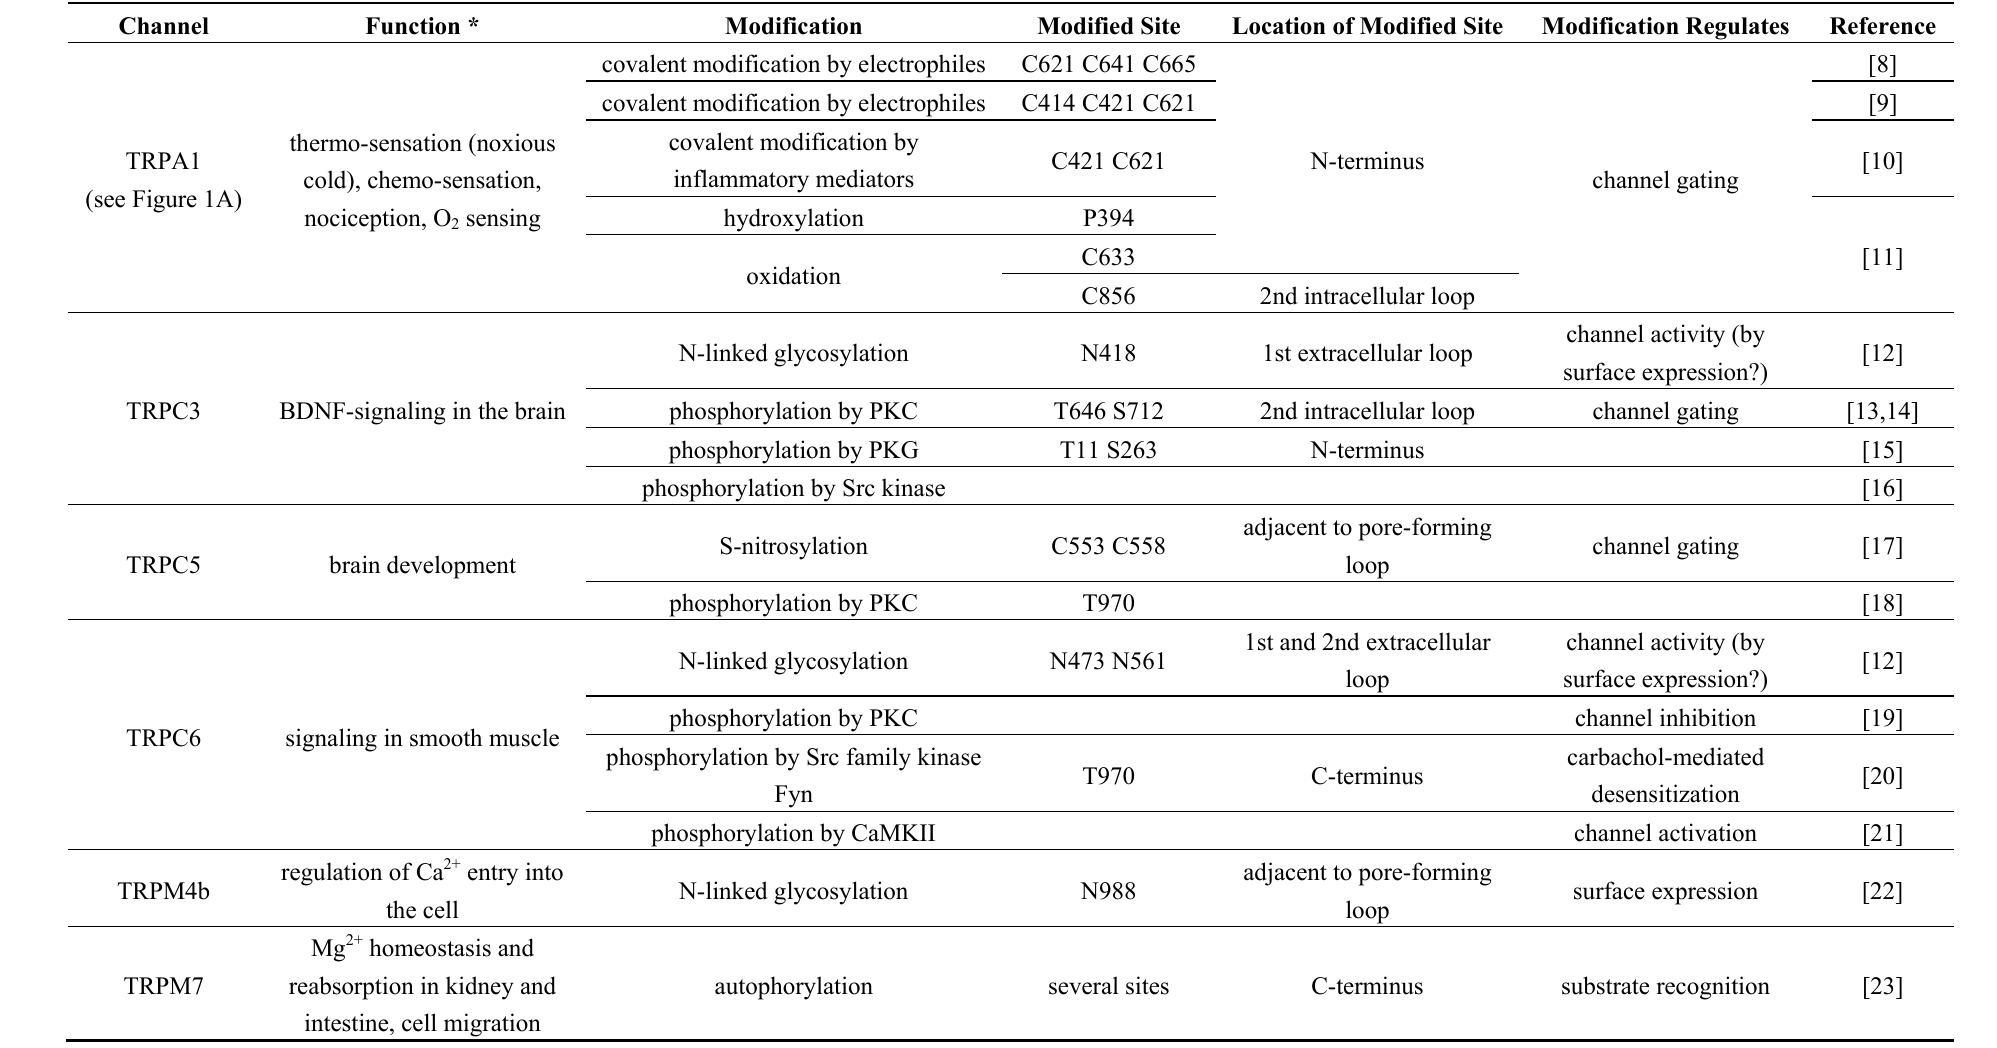
Table 1. Post-translational modifications of TRP channels. * partially as proposed by